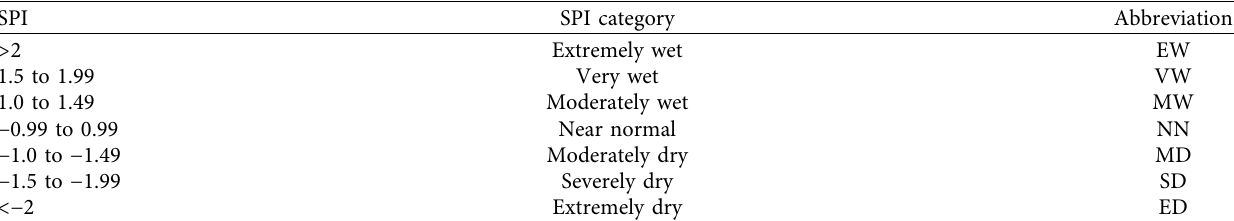
Figure 1: Study area and stations: Yes¸ilırmak Basin, Kızılırmak Basin, and Konya Closed Basin (shown as within the green, red, and blue boundaries, respectively). Table 2: Drought classes based on SPI values.